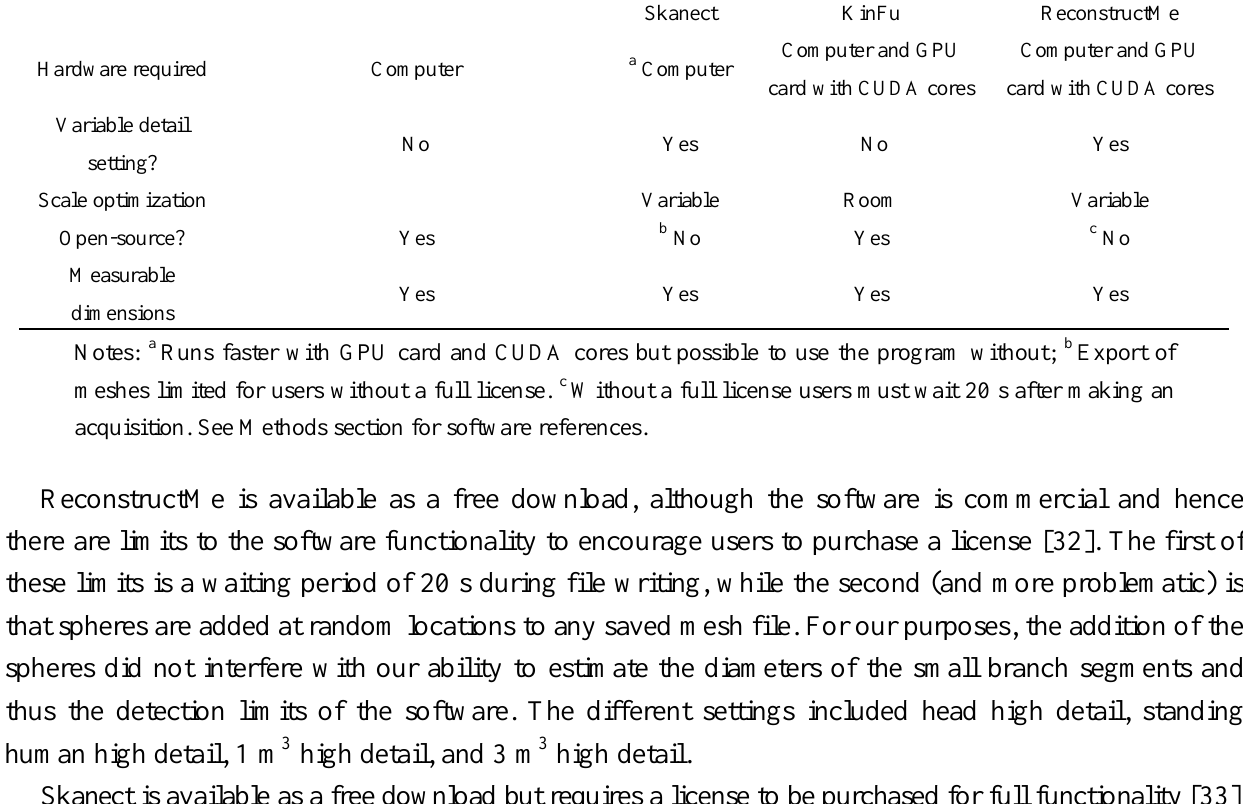
Table 2. Comparison of 3D data capture methods: static acquisition using OpenNI grabber and different software for 3D scanning. Static Acquisition (OpenNI Grabber) Skanect